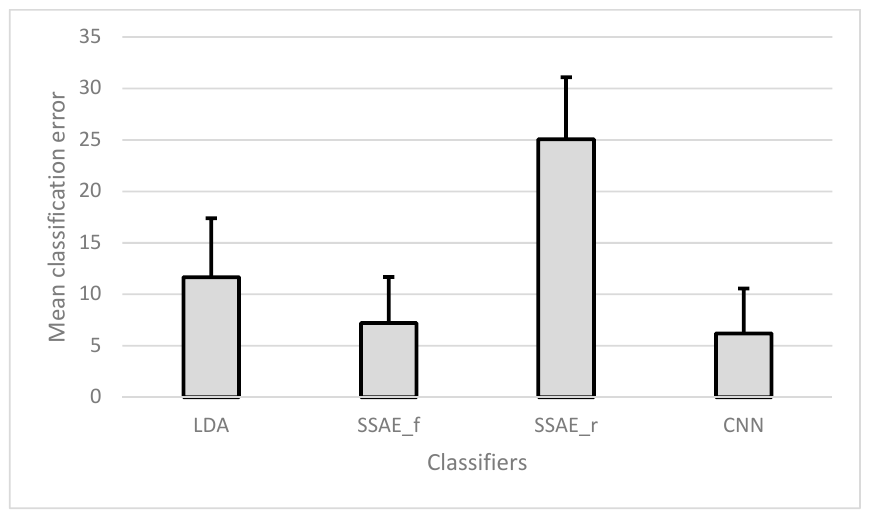
Figure 6. Mean (and SD) classification error of all classifiers for between-sessions analysis with two-fold cross-validation averaged over the 15 days.